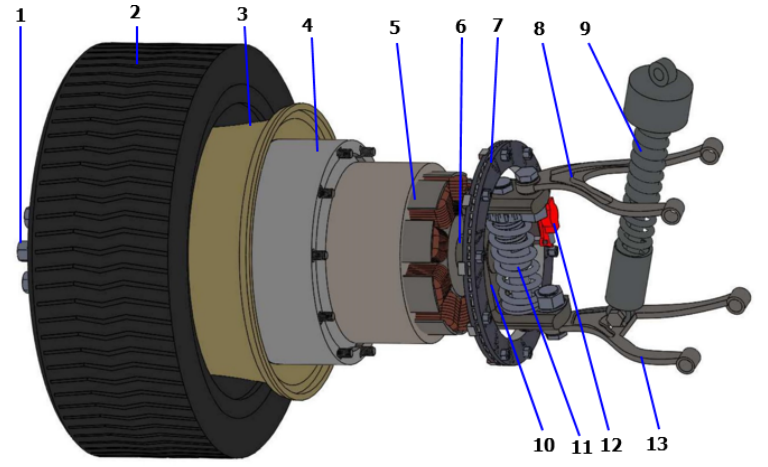
Figure 11. Physical structure of the HARMRD for electrical IWM suspension. 1. Nuts, 2. Tire, 3. Wheel, 4. Motor rotor, 5. Motor stator, 6. Hub shaft, 7. Brake disk, 8. Upper control arm, 9. HARMRD, 10. Hub, 11. DAV damper, 12. Brake caliper, 13. Lower control arm.